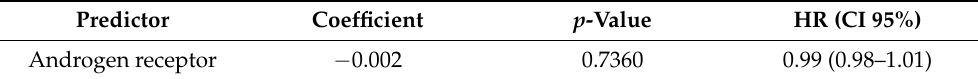
Table 2. The AR distribution.